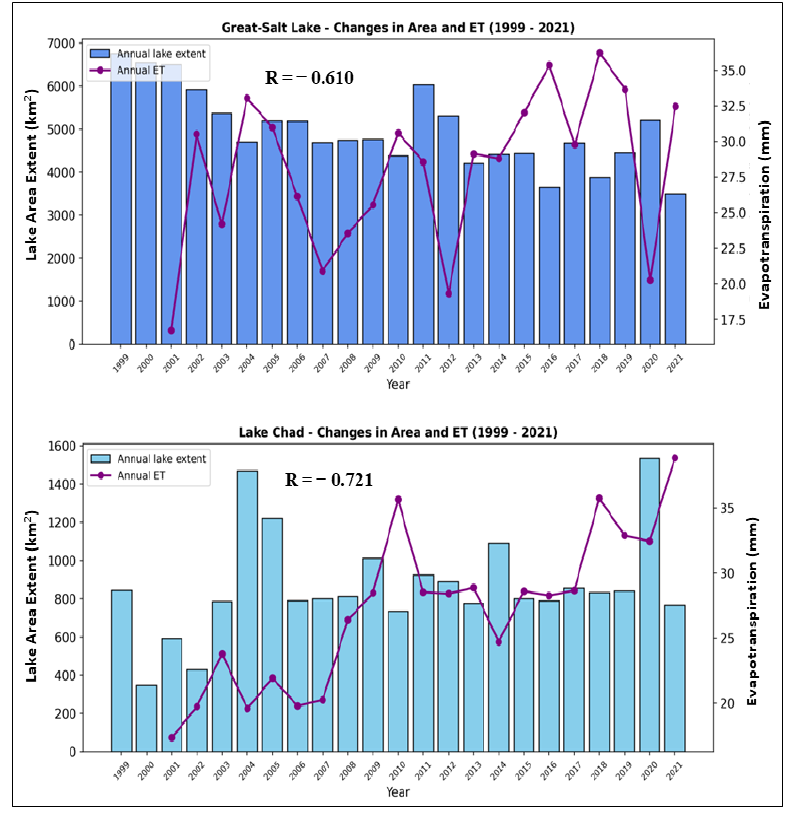
Figure 7. Temporal variation of annual lake area and evapotranspiration variation in GSL basin ( top ) and LC basin ( bottom ). and LC basin ( bottom